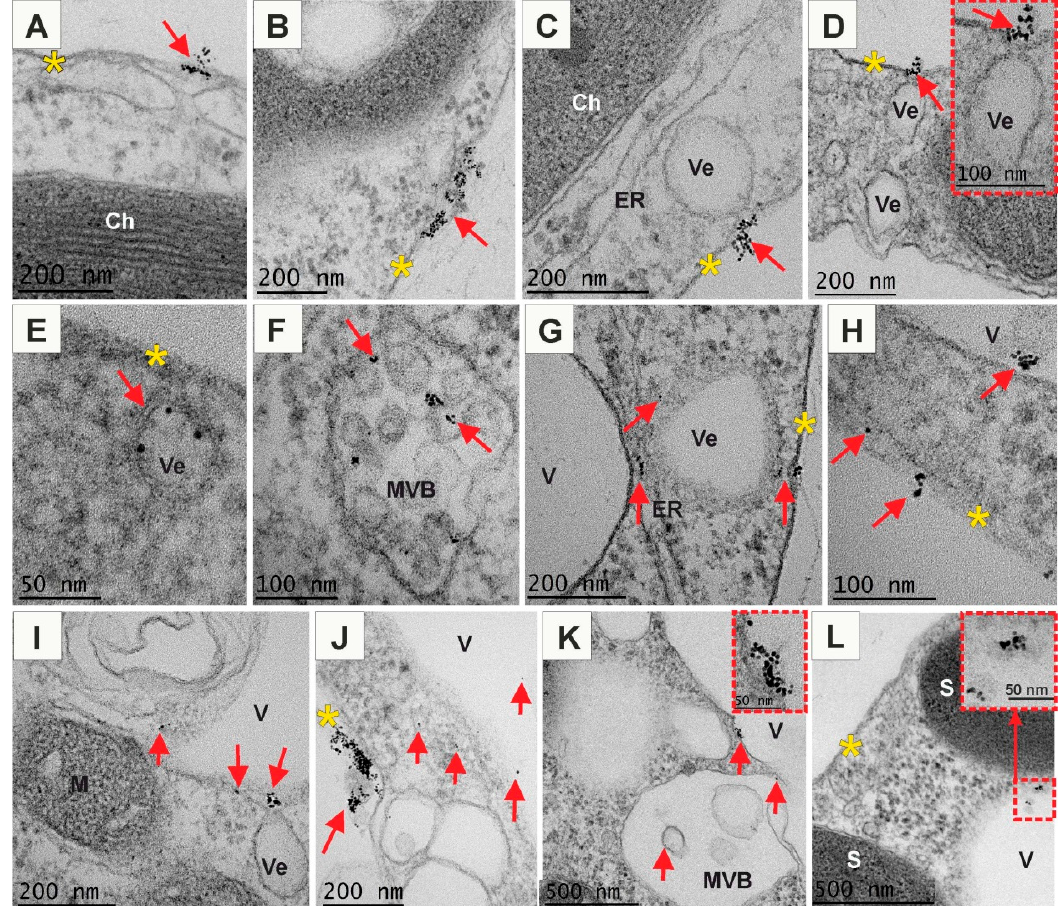
Figure 6. Ultrastructure of Arabidopsis protoplasts treated with (-) AuNPs ( A–L ). (-) AuNPs passed through the PM that provided the first barrier between the environment and cytoplasm. (-) AuNPs were detected on the PM surface, bound to the PM or in cytoplasm just below PM ( A , B , H ). They were also mostly found in the vesicles or in the vicinity of the vesicles ( C , D , E , G ), in the multivesicular bodies ( I ), in the cytoplasm ( G , H , J ) or in the vacuole ( H , V , J , K , L ); red arrows indicate the presence of AuNPs; yellow asterisks indicate plasma membrane barrier; Ch—chloroplast; ER—endoplasmic reticulum; M—mitochondria; MVB—multivesicular body; S—starch grain; V—vacuole; Ve—vesicle.